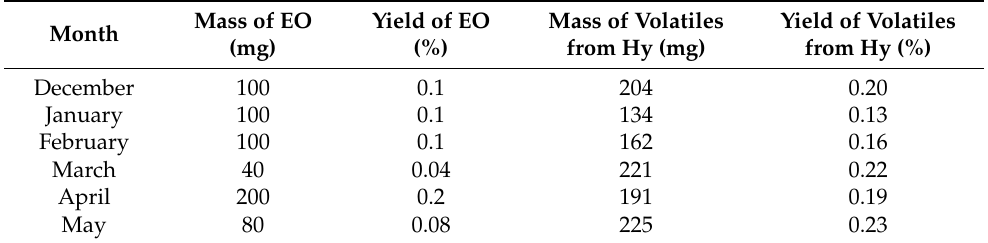
Table 1. Yield of obtained volatile compounds from essential oils (EOs) and hydrosols (Hy) of Olea europaea cv.